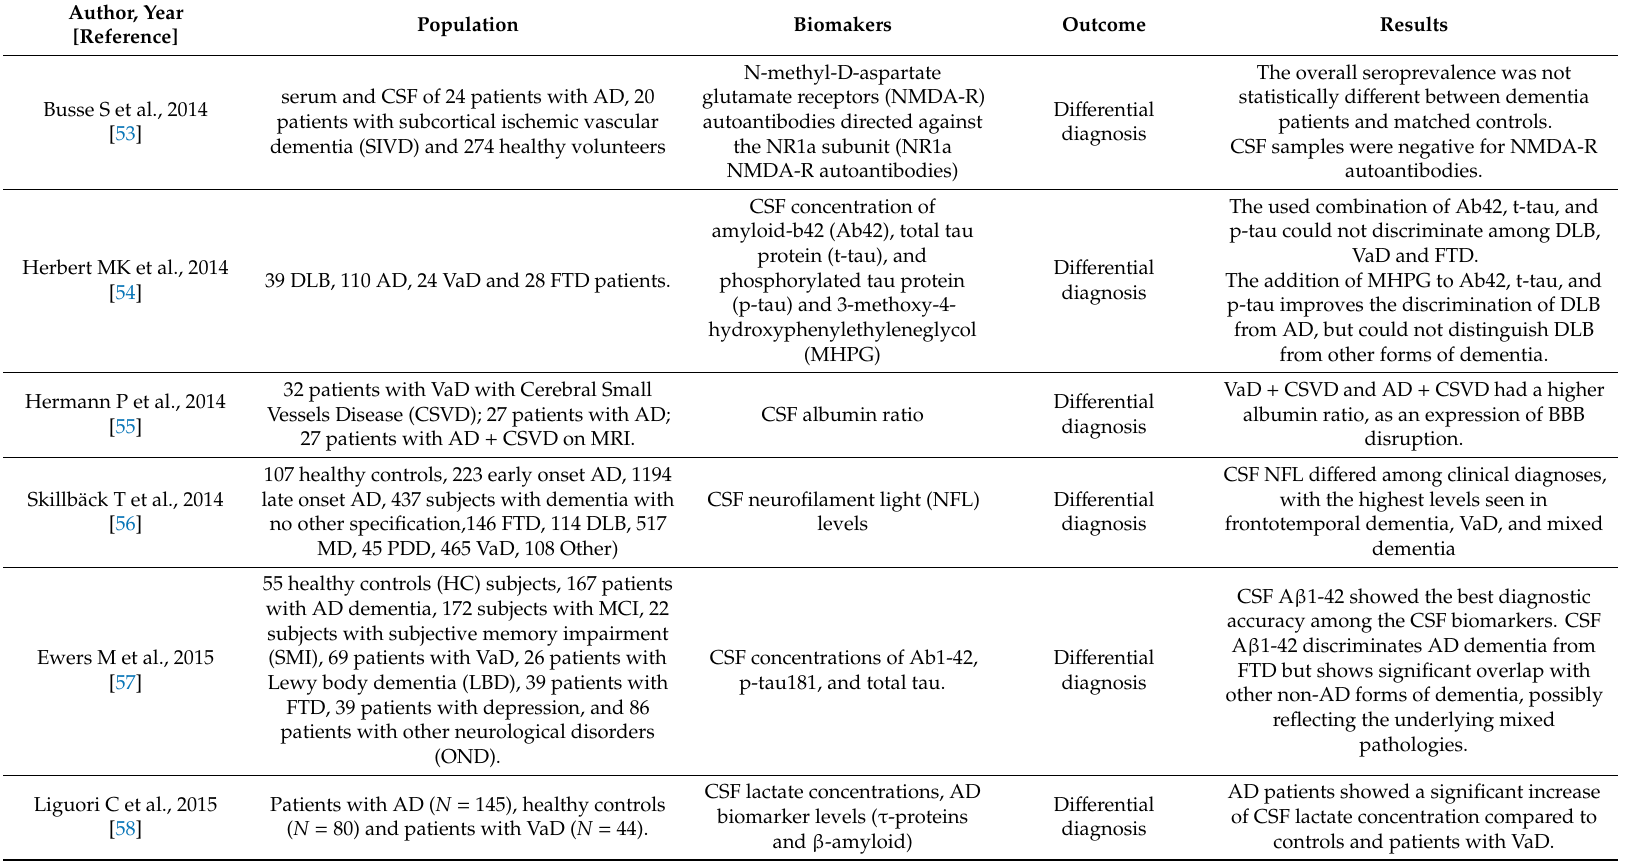
Table 2. CSF biomarkers and